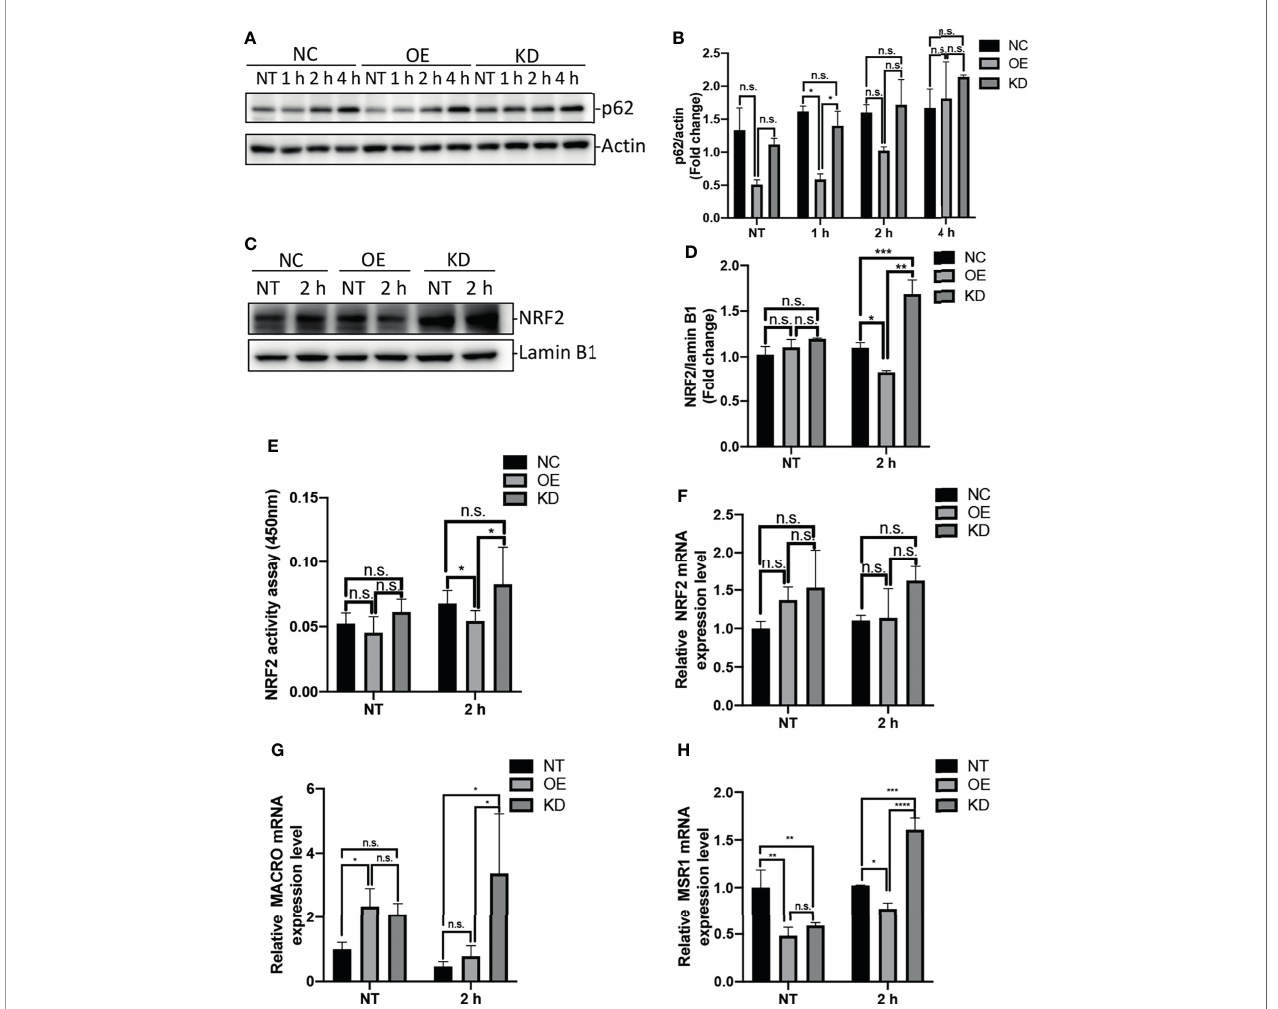
FIGURE 4 | Egr-1 suppressed NRF2 activation through reducing the levels of p62 in macrophages in response to P. aeruginosa infection. Egr-1 NC, OE and KD RAW264.7 cells were infected with P. aeruginosa PAO1 at an MOI of 10 for 1 h, 2 h, 4 h or left untreated (NT). Cell lysates were subjected to Western blotting for determining the p62 protein expression levels, and actin was used as a loading control. Blots are representative of three independent experiments (A) . Densitometry analysis of the p62 protein levels was normalized to actin, and data were presented as fold change (B) (n = 3 ± SEM; n.s., not signi fi cant, *p < 0.05). The nuclear proteins were extracted from the Egr-1 NC, OE and KD cells infected with P. aeruginosa PAO1 for 2 h or left untreated, and subjected to Western blot analysis for examining the protein levels of NRF2 in nucleus. Blots are representative of three independent experiments (C) . Densitometry analysis of the NRF2 protein levels in nucleus was normalized to lamin B1, and data were presented as fold change (D) (n = 3 ± SEM; n.s., not signi fi cant, *p < 0.05, **p < 0.01, ***p < 0.001). The nuclear extracts from NT and P. aeruginosa 2 h infected Egr-1 NC, OE and KD cells were subjected to transcription factor ELISA for determining NRF2 activity (E) (n = 6 ± SEM n.s., not signi fi cant, *p < 0.05). The total RNA isolated from NT and P. aeruginosa 2 h infected Egr-1 NC, OE and KD cells were reverse transcribed to cDNA and subjected to real-time quantitative PCR for analyzing the mRNA transcription levels of NRF2, MACRO and MSR1. The mRNA levels of NRF2, MACRO and MSR1 were normalized to endogenous control b -actin (F – H) (n = 3 ± SEM; n.s., not signi fi cant, *p < 0.05, **p < 0.01, ***p < 0.001, ****p <